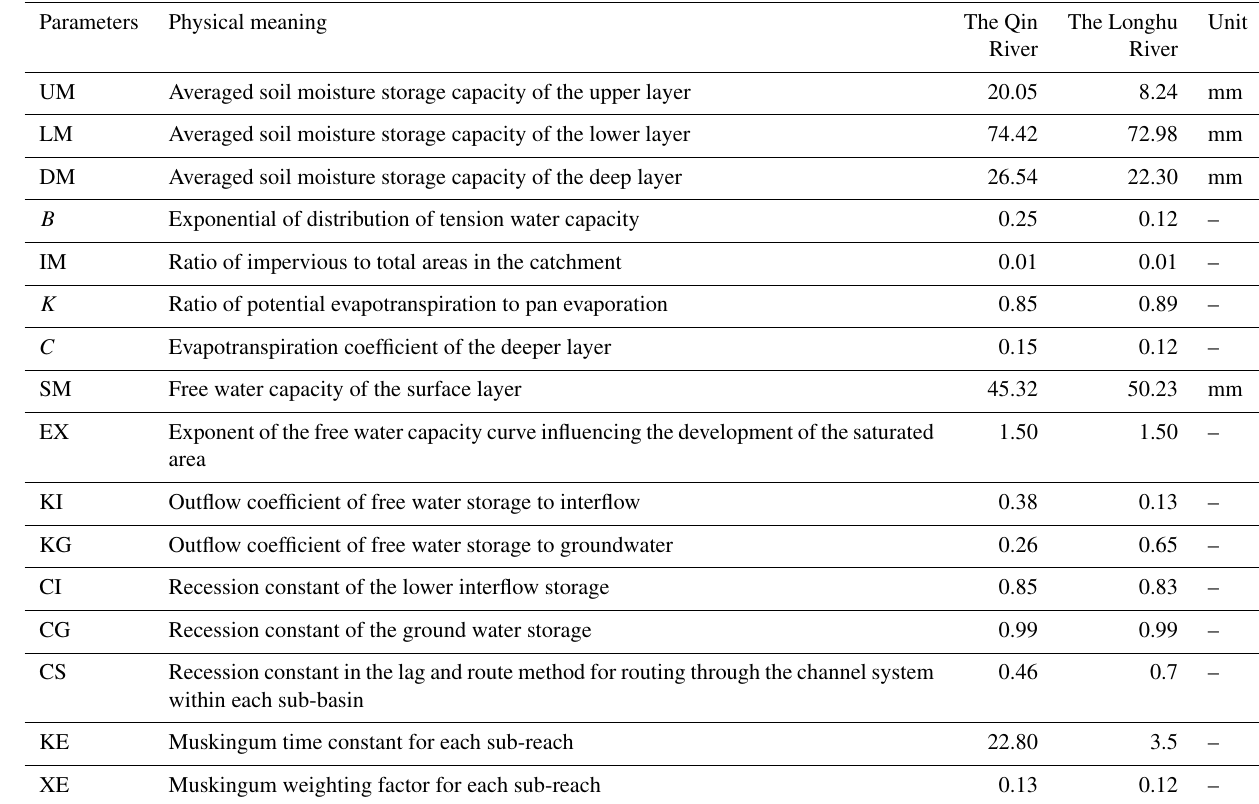
Table 2. Calibrated parameters of the XAJ model. Parameters